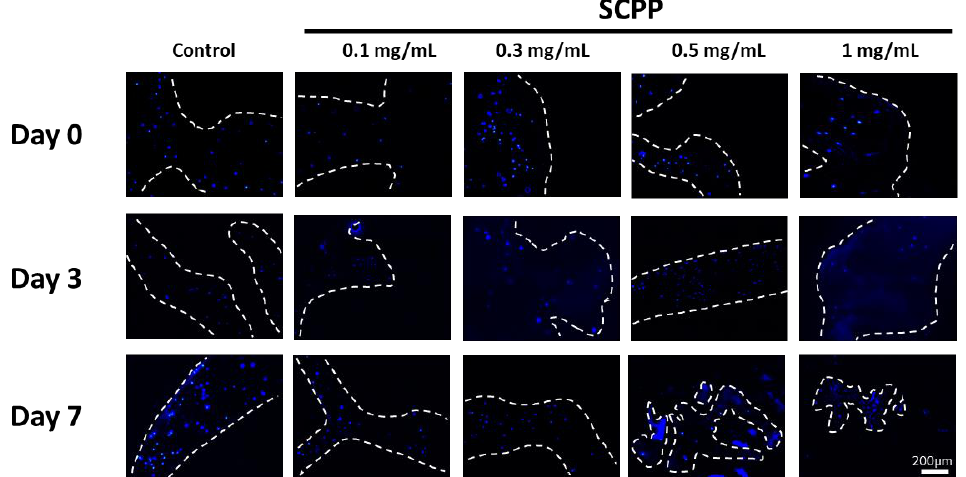
Figure 9. Cryosections of cell-laden scaffolds after printing (day 0), 3, and 7 days indicate cell survival within the biomaterial scaffold through DAPI staining. The presence of cells until day 7 indicates continuous cell growth within the scaffolds. Dashed lines represent the borders of the scaffolds.